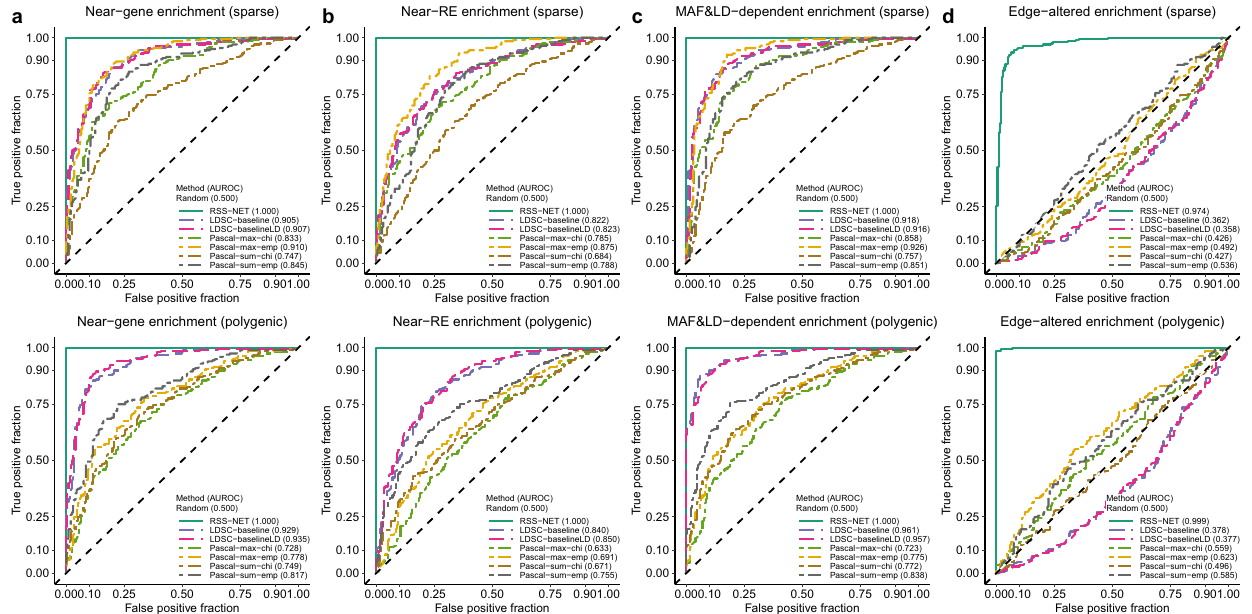
Fig. 3 Robustness of RSS-NET to model mis-speci fi cation in enrichment analyses. Here positive datasets were generated from M 1 with θ > 0 and σ 2 > 0 (Fig. 2c). Negative datasets were simulated from four scenarios where genetic associations were enriched in: a a random set of near-gene SNPs; b a random set of near-RE SNPs; c SNPs with MAF- and LD-dependent effects; d a random edge-altered network. By this design, RSS-NET was mis-speci fi ed in all four scenarios. Similar to positive datasets, the simulated false enrichments in all negative datasets manifested in both association proportion (more frequent) and magnitude (larger effect). RSS-E was excluded here because of its poor performance shown in Fig. 2c. The rest is the same as Fig. 2. Simulation details and additional results are provided in Supplementary Figs. 3 –